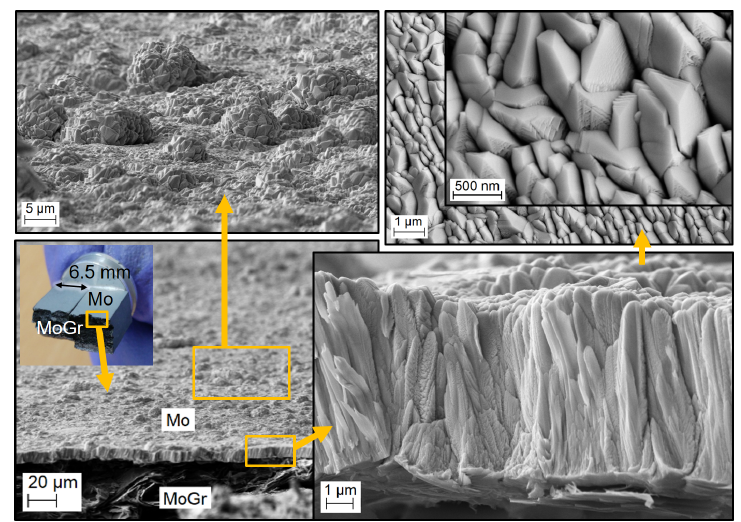
Figure 24. SEM observations of a Mo-coated MoGr sample produced with DCMS. The fracture surface ( bottom ) and the coating surface ( top ) are shown.